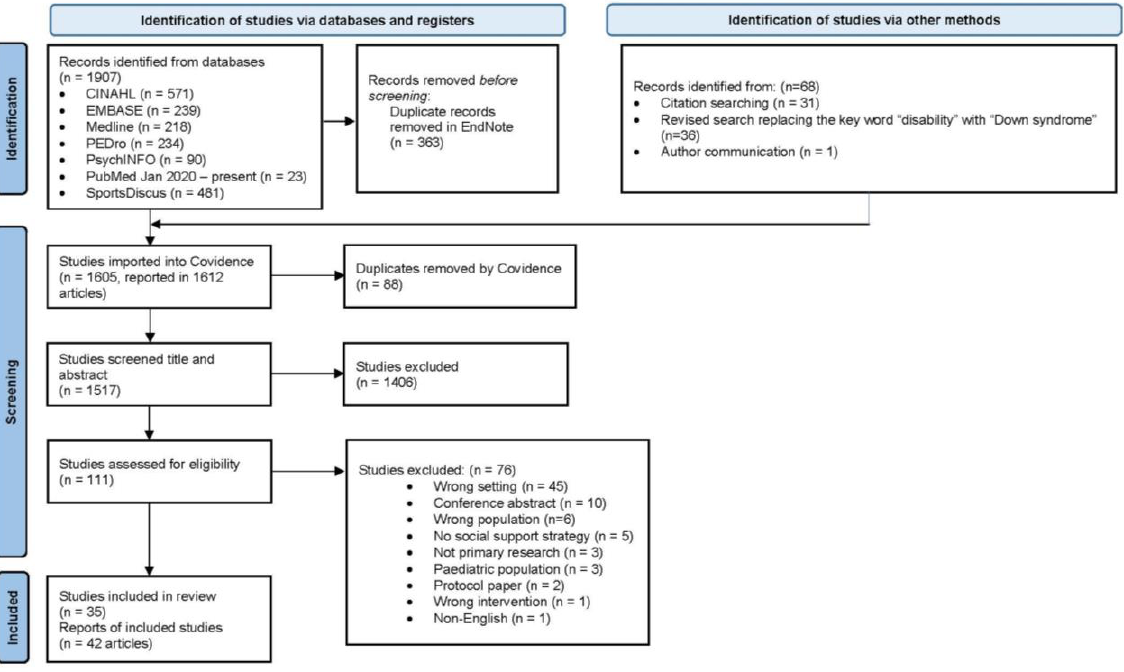
Figure 1. PRISMA flowchart of study selection.